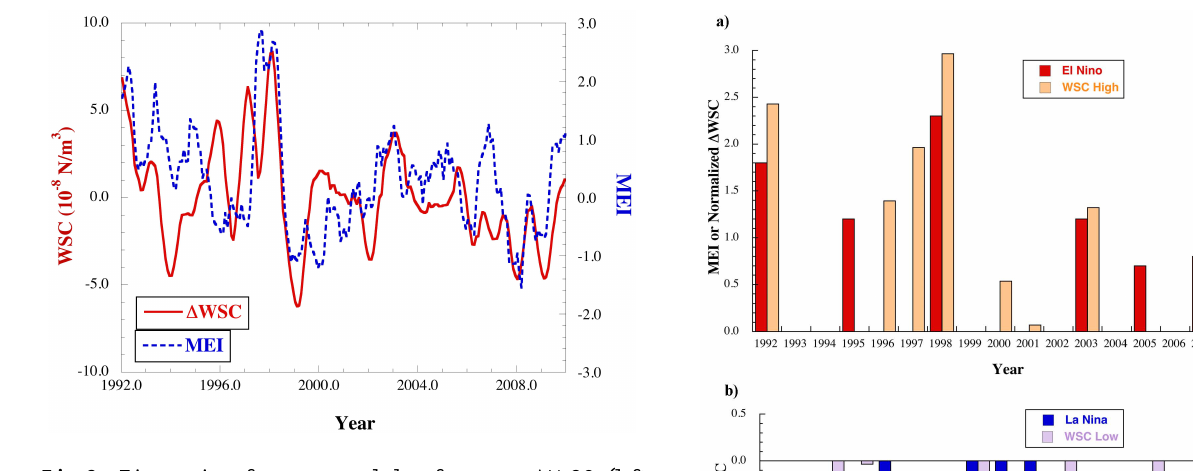
Fig. 3. Time-series of non-seasonal, low-frequency 1 WSC (left axis) and MEI (right axis). 1 WSC represents the difference in the anomalous WSC north of 35 ◦ N and anomalous WSC south of 35 ◦ N. See text for details.